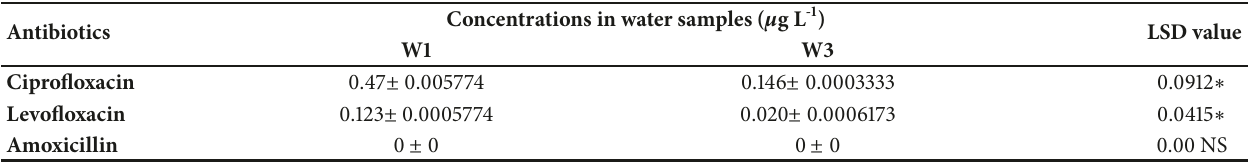
Table 2: Antibiotics in raw and finished water in the Al-Wihda treatment plant . Mean ± SD values for the three antibiotics between the raw and finished water( 𝜇 g L −1 ) are listed.Statistical analyses were done with ∗ P < 0.05 ,between W1and W3.The asteriskrepresentsthe significant differences. NS refers to no significant differences.